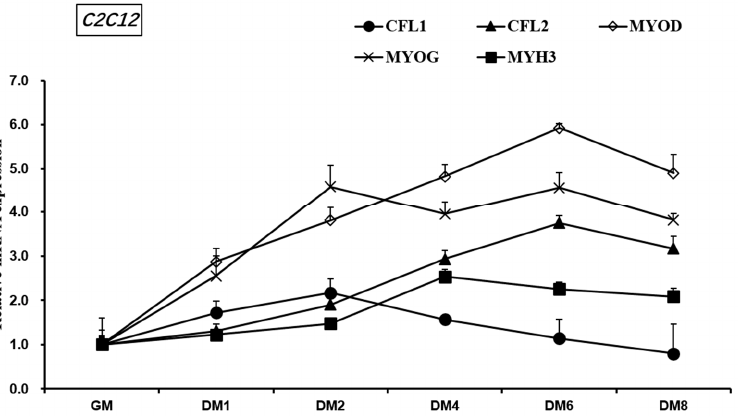
Figure 5. Expression trends of CFL1 and CFL2 gene and myogenesis factors were detected in C2C12 cells. C2C12 cells were induced for 1, 2, 4, 6, and 8 days by 2% horse serum, and the relative expression trends of CFL1gene, CFL2 gene, and myoblast differentiation marker genes MYOD, MYOG, and MYH3 were detected by qRT-PCR. The mRNA expression level was normalized to GAPDH. Data are mean ± SE of n = 3 independent experiments, each performed in triplicate. GM, growth medium. DM, differentiation medium. During 1–8 days after induction of C2C12 differentiation (DM1-8), the overall expression trend of myoblast marker factors MYOD, MYOG, MYH3, and CFL2 gene was higher than that of C2C12 during growth and proliferation (GM), while the final expression level of CFL1 (DM8) was lower than that of C2C12 during growth (GM). The expression of MYOD increased from 0 to 6 days (GM-DM6) and then decreased from 6 to 8 days (GM6-8). The expression level of MYOD was higher than that of MYOG, MYH3, CFL1, and CFL2 in the late 6–8 days (GM6-8) of differentiation. The expression of MYOG increased from 0 to 2 days (GM-DM2), decreased from 2 to 4 days (DM2-4), increased from 4 to 6 days (DM4-6), and decreased from 6 to 8 days, and the expression level of MYOG was the highest on 2 days (DM2). MYH3 has an upward trend in 0–4 days (GM-DM4) and a larger upward trend in 2–4 days (DM2-4), and a downward trend in 4–8 days (DM4-8). However, the expression level of CFL1 showed an upward trend in the early 1–2 days (DM1-2) of differentiation and gradually decreased in the 4–8 days (DM4-8) after differentiation. On the eighth day of differentiation, the expression level of CFL1 was lower than that in the growth period of C2C12; CFL2 showed an upward trend in 0–6 days and a larger increase in 2–6 days (DM2-6), and CFL2 showed a down- ward trend in 6–8 days (DM6-8) in the late differentiation stage. The expression level of CFL1 was higher than that of CFL2 in the early stage of differentiation 0–2 days (GM-DM2), while the expression level of CFL2 was higher than that of CFL1 in the 2–6 days differen- tiation stage, and the expression level of CFL2 always increased in the 0–6 days (GM- DM6), and the expression level of CFL1 was decreased. 3.5. Regulation of CFL1 and CFL2 Genes on Myoblast Differentiation In order to determine the involvement of CFL1 and CFL2 in myogenic differentiation and to explore the roles of CFL1 and CFL2 in the process of myogenic differentiation and their relationship, we constructed adenovirus overexpression vectors and adenovirus interference vectors of CFL1 and CFL2. HEK293 cells packaged adenovirus and collected adenovirus venom, and then the adenovirus venom of CFL1, CFL2 interference, and overexpression vectors were transfected into PBMs and cell differentiation was induced. qRT-PCR detec- tion showed that after transfection of pAd CMV-CFL1 (CFL1-OE), pAd CMV-CFL2 (CFL2-OE), pAd-shRNA-CFL1 (shCFL1), and pAd-shRNA-CFL2 (shCFL2), the